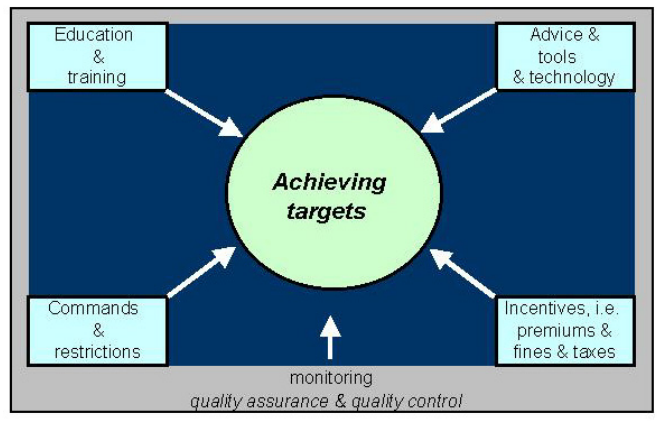
FIGURE 4. Framework showing tools for achieving targets in improvement of N management (from plenary presentation by O.